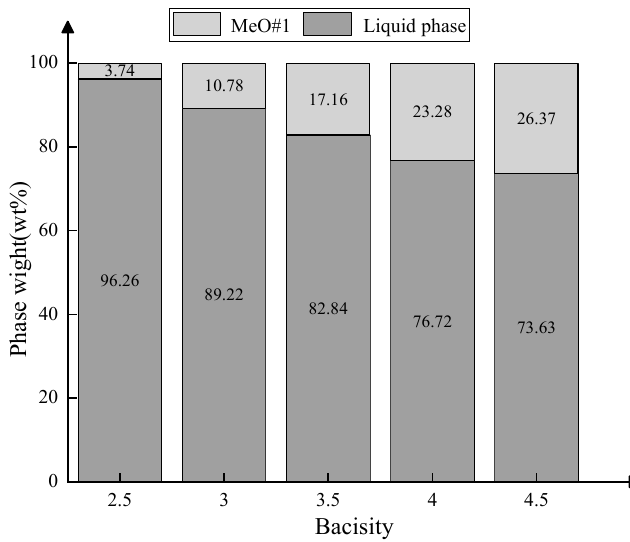
Figure 3. Relationship between the molten slag phase and the basicity at 1600 °C .